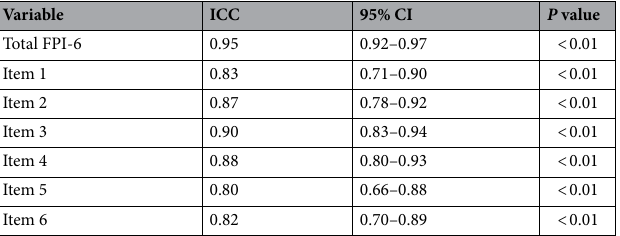
Table 3. Test–retest reliability of the FPI-6. Total FPI-6, Foot total score of FPI-6; ICC, intraclass correlation coefficient’ Item 1, talar head palpation; Item 2, curves above and below the lateral malleolus; Item 3, a bulge in the region of the talonavicular join; Item 4, eversion and inversion of the calcaneus; Item 5, congruence of the medial longitudinal arch; Item 6, adduction and abduction of the forefoot in relation to the rear foot.